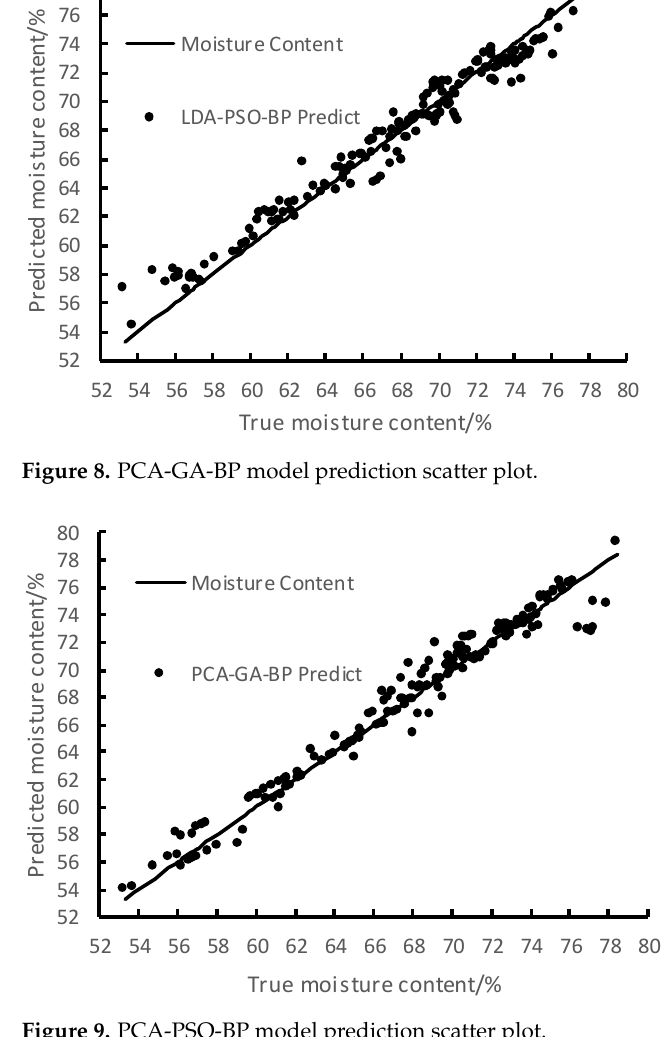
Figure 9. PCA-PSO-BP model prediction scatter plot.